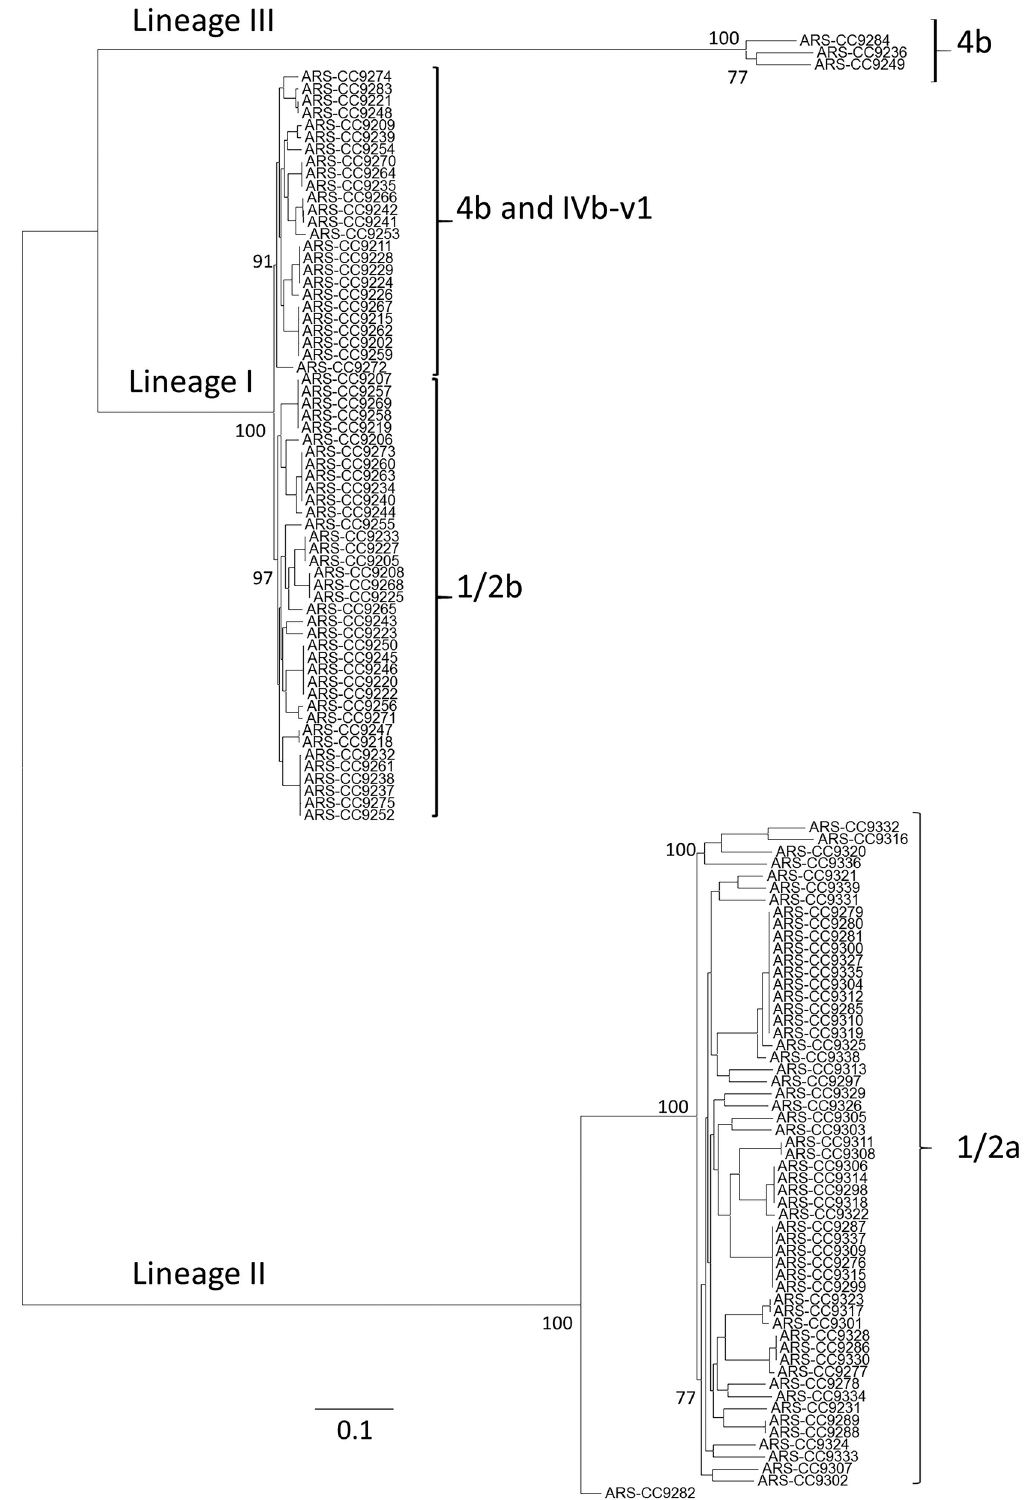
Fig 1. Maximum likelihood phylogenetic tree of 121 L . monocytogenes isolates collected from US dairies. The displayed phylogeentic tree is based on 166,603 core-genome SNPs identified among the study isolates. The phylogenetic tree was inferred using the General Time Reversible model of nucleotide substitution in RAxML with 100 bootstrap replicates. Bar length represents number of substitutions per site. https://doi.org/10.1371/journal.pone.0197053.g001 PLOS ONE | https://doi.org/10.1371/journal.pone.0197053 May 9,